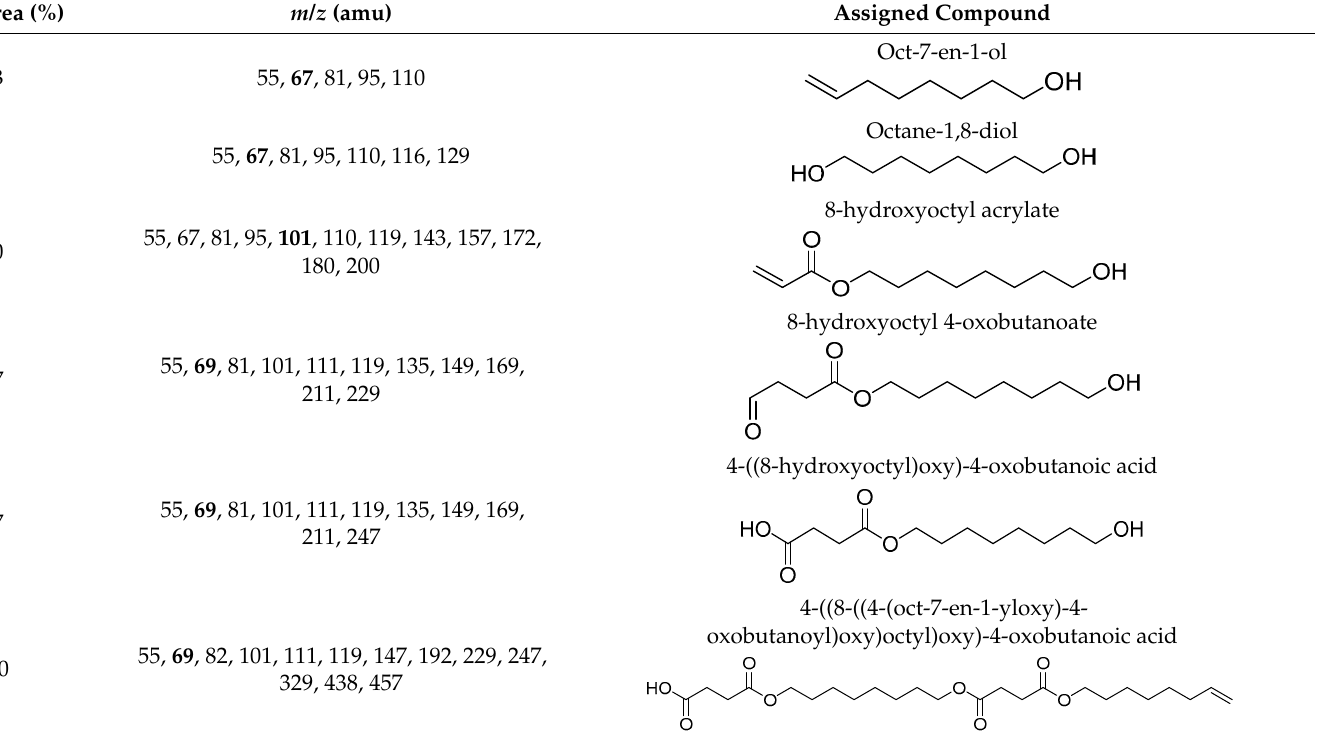
Figure 6. Mass spectra of the major decomposition products of POSu. Table 7. Thermal decomposition products of PDeSu. Peak Name m/z